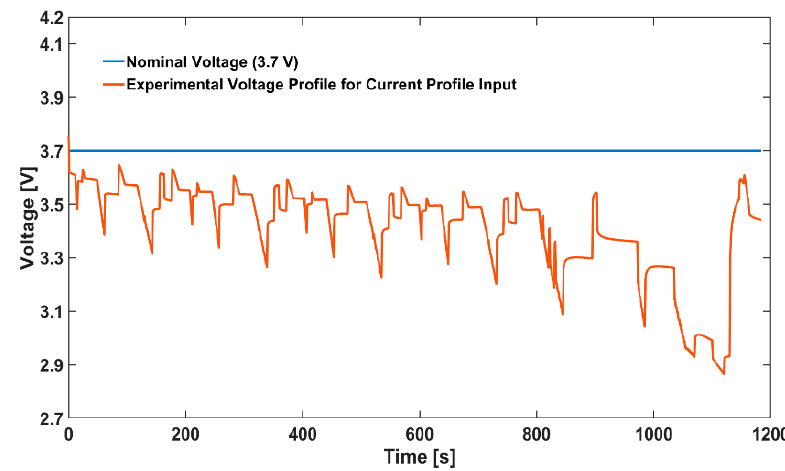
Figure 7. Comparison between fixed nominal voltage and experimental voltage response for current-based NEDC at − 15 °C ambient temperature and 65% starting SOC.